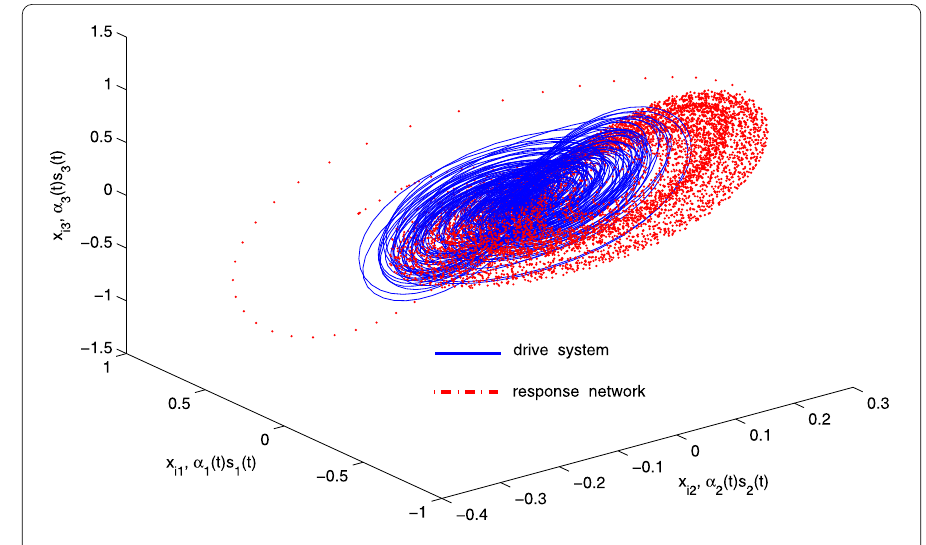
Figure 1 Chaotic behavior of drive system (38) and response network (39) with the time-varying scaling function matrix α ( t ) = diag(0.6sin( 2 π